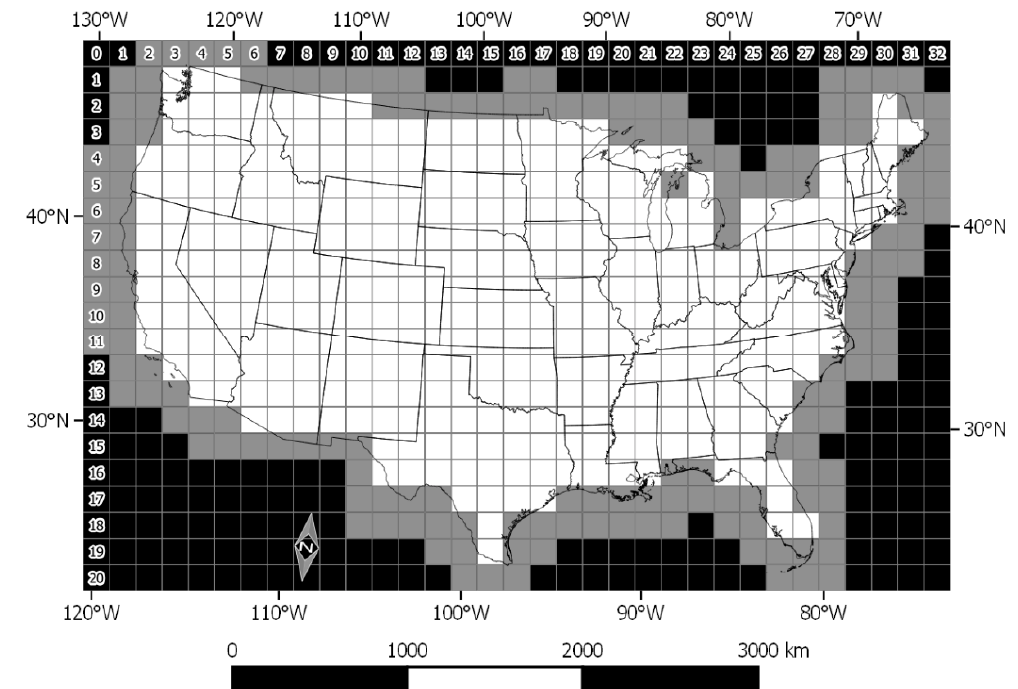
Figure 1. CONUS ARD tile locations with horizontal (h = 0 to 32) and vertical (v = 0 to 20) tile coordinates. The ARD tile boundaries are shown by grey lines and are defined by 5000 × 5000 30 m pixels in the Albers equal area projection (see [2] for the projection parameters); national and state boundaries are shown as black lines. Tiles where at least 50% of their coverage is within the CONUS (defined by vector data, [16]) are shown white, otherwise shown grey.